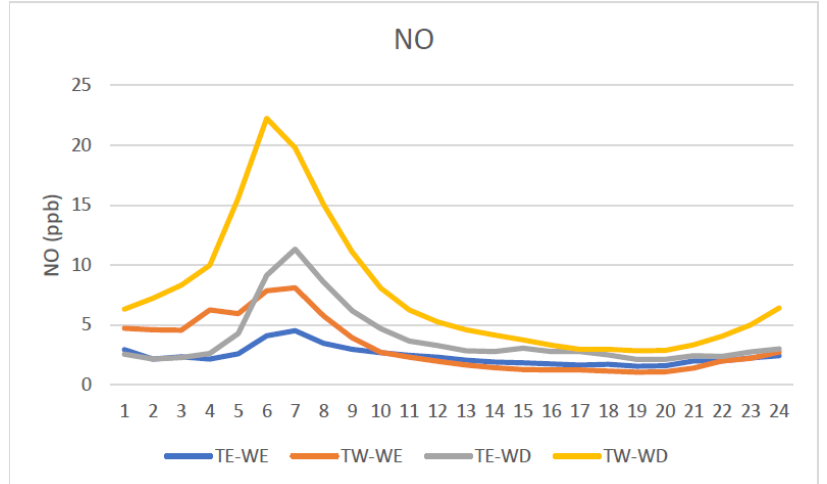
Figure 2. Nitrous oxide concentration (ppb) during the baseline period (2010–2019) for Toronto West (TW) and Toronto East (TE) for weekends (WE) and weekdays (WD).